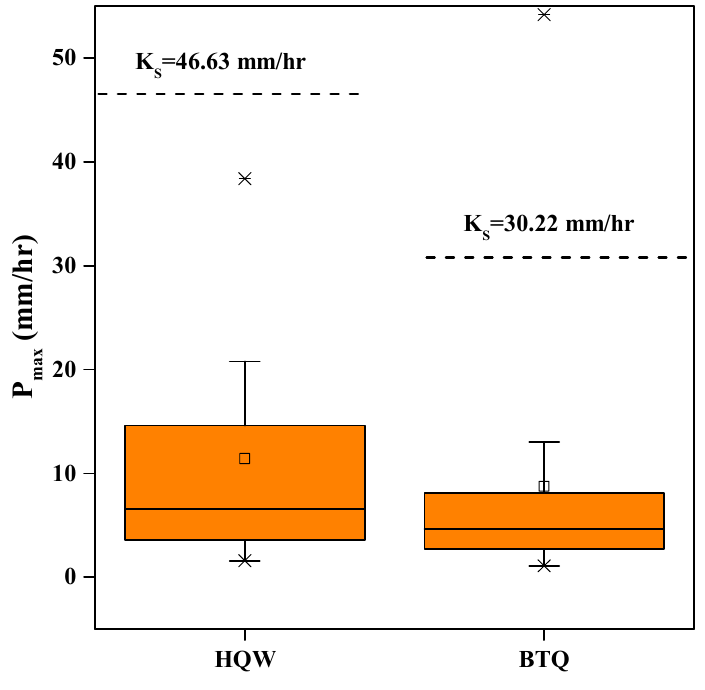
Figure 6. Boxplots of peak rainfall intensity with the saturated hydraulic conductivities of HQW and BTQ marked in dotted lines.